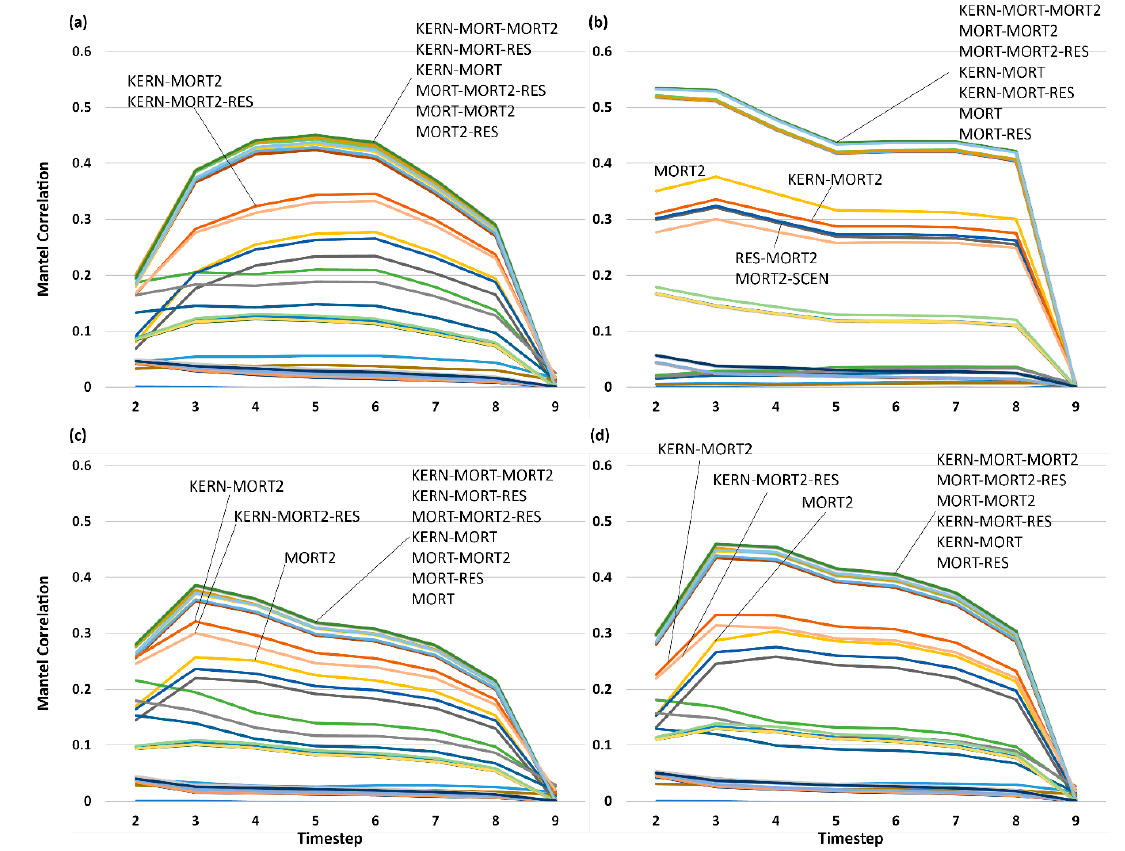
model matrix combining KERN, MORT2 and RES model matrices by addition.